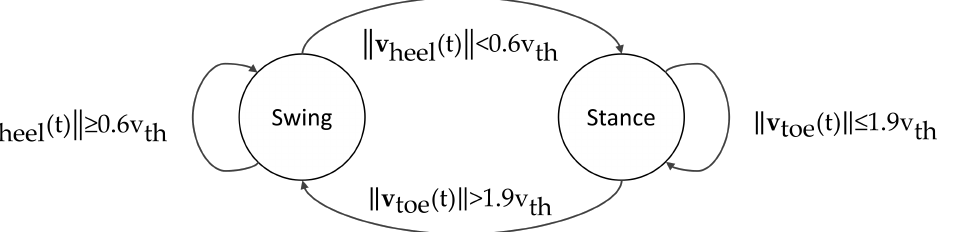
Figure 4. A state machine to detect the current state of the gait cycle, based on the previous state and a condition on the velocity of the heel or toe. The velocity v th is equal to the norm of the average velocity of the pelvis segment for each